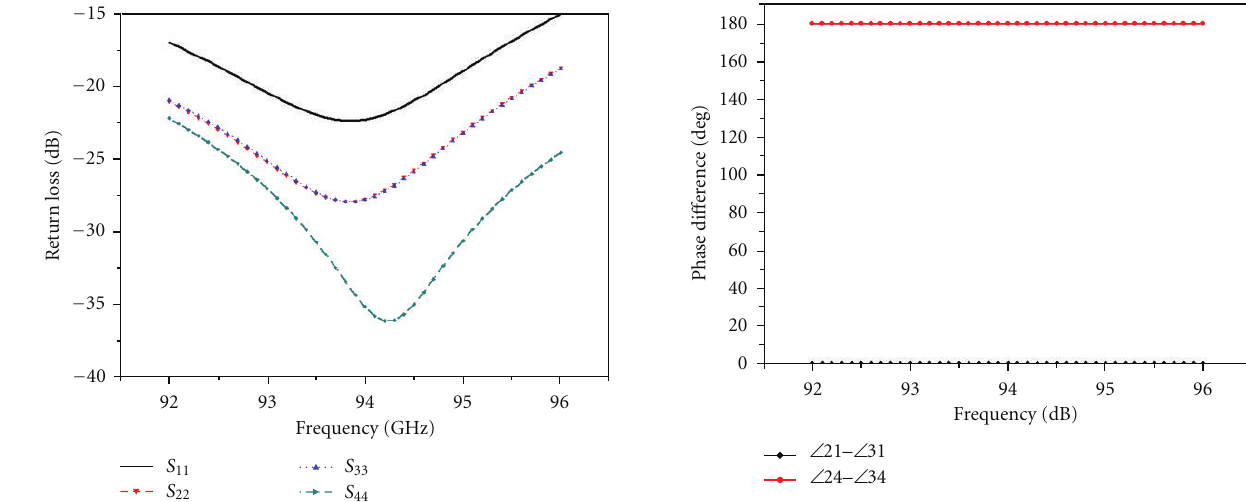
Figure 7: Phase characteristics of transmission coe ffi cients.